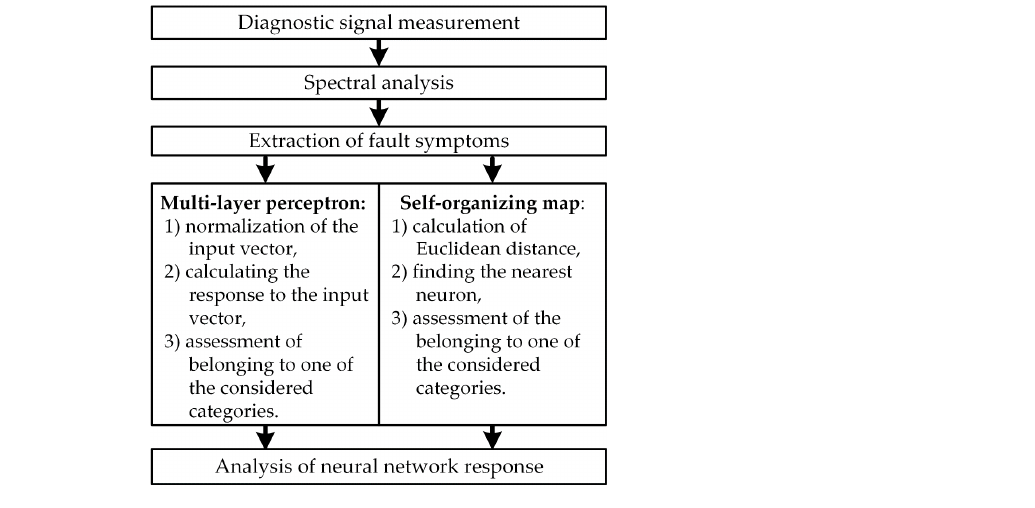
Table 1. Rated parameters of the tested PMSM. Parameter